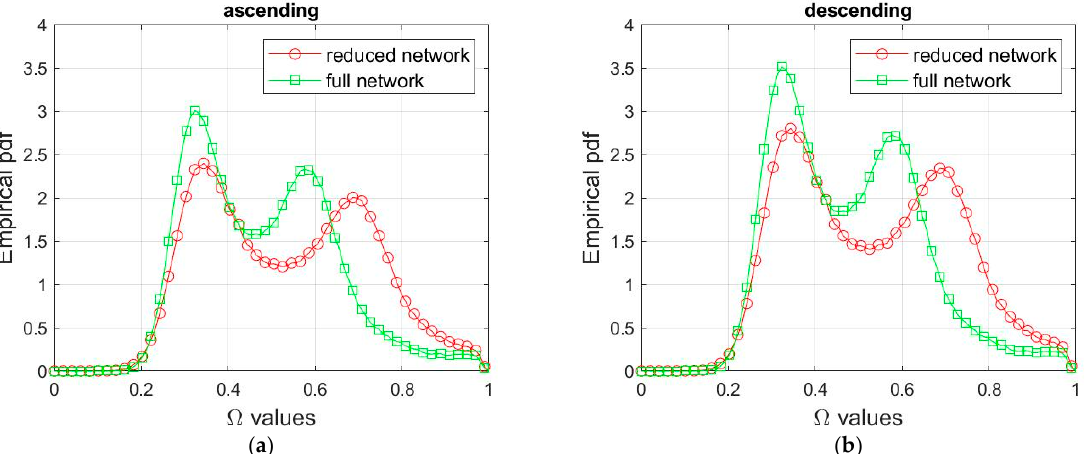
Figure 5. Histogram of the equivalent temporal coherence values computed over the whole area of interest, comparing full (green) and reduced (red) interferogram network. Sentinel-1 ascending ( a ) and descending ( b ) data.